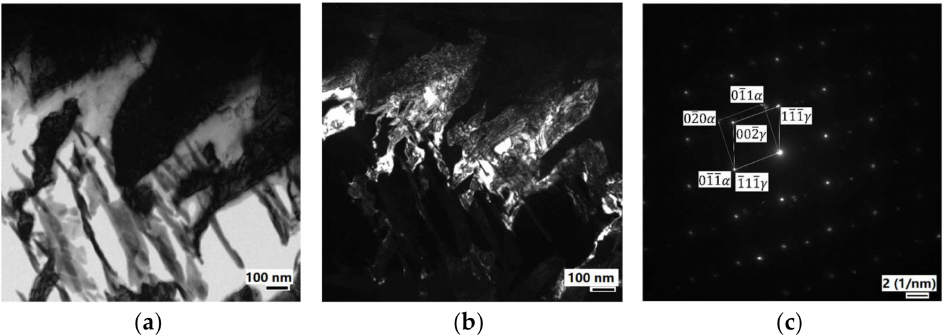
Figure 4. TEM microstructures of sample transformed at 707 ◦ C for 15 s: ( a ) Bright field image; ( b ) selected area diffraction pattern showing the Kurdjumov–Sachs orientation of α / γ ; ( c ) dark field image of